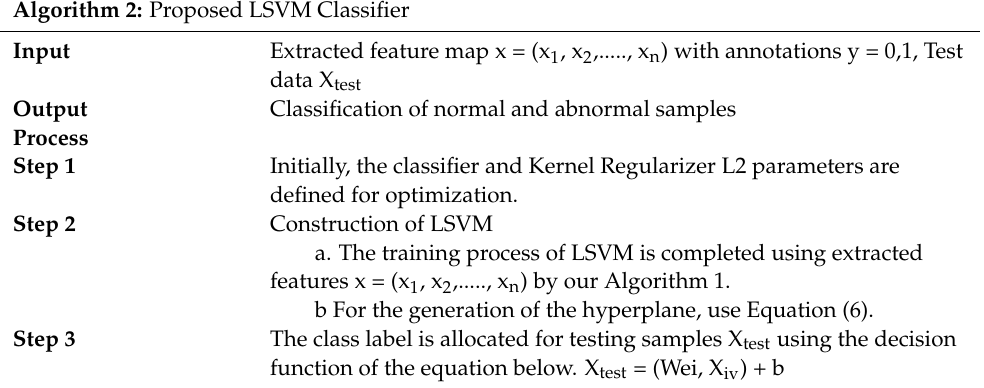
Algorithm 2: Proposed LSVM